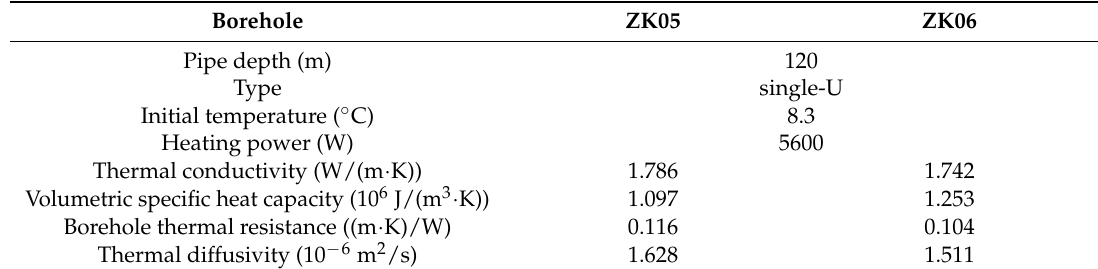
Table 3. The standard thermal response test (TRT)